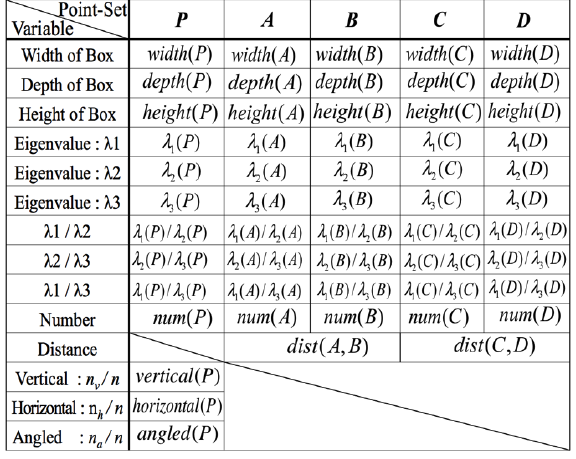
Table 1. Feature variables for pole-like objects